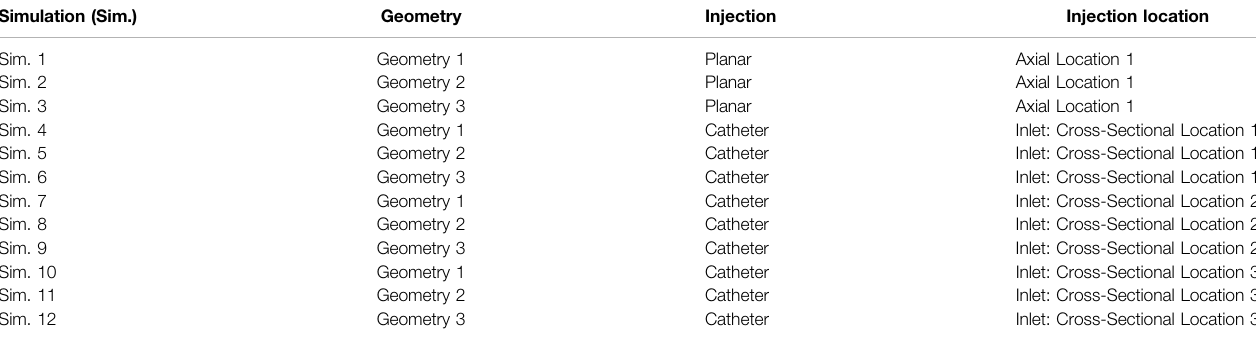
TABLE 1 | Study design giving an overview of all simulations and their corresponding geometry, injection type and location. Simulation (Sim.)